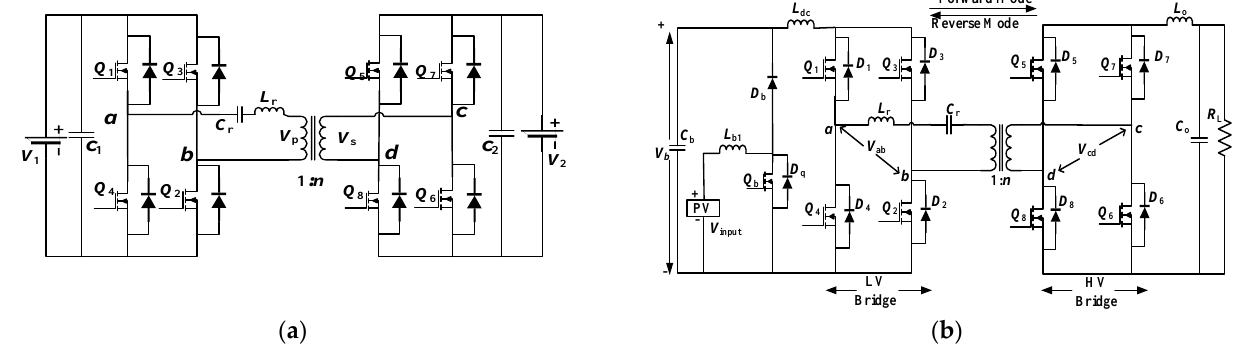
Figure 2. Isolated Bidirectional DC – DC Converter ( a ) Voltage-fed DAB converter ( b ) Current-fed DAB converter.